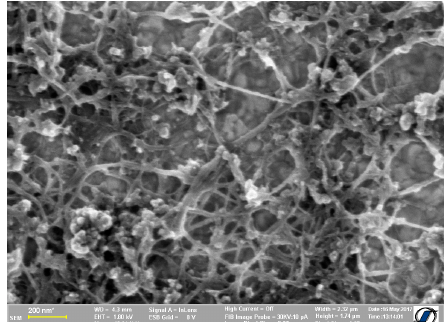
Figure 5. SEM image of the sulfonated SWCNTs.